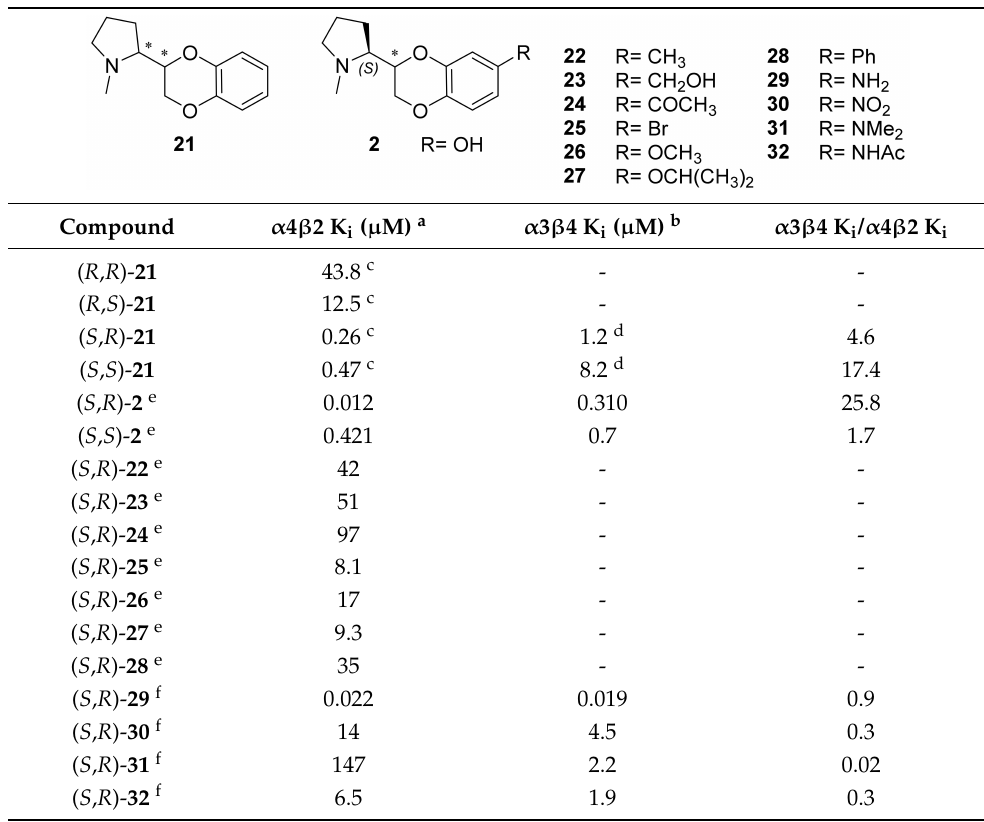
Table 4. Binding affinity data at α 4 β 2 and α 3 β 4 nAChRs and α 4 β 2 vs. α 3 β 4 selectivity ratio